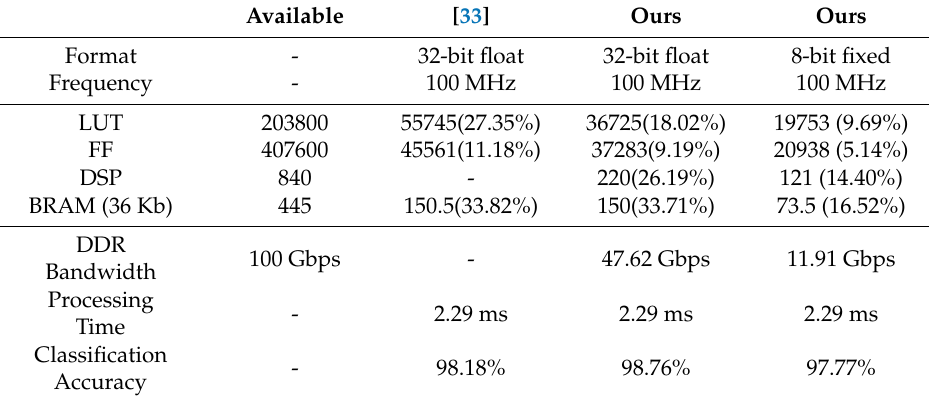
Table 9. Experimental results of the floating-point model and the 8-bit quantized model in FPGA.